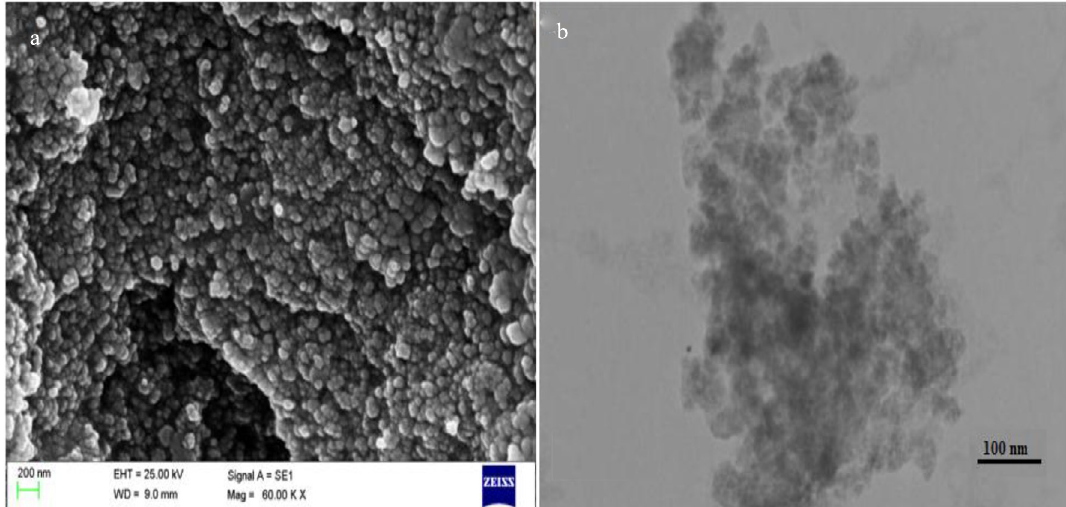
Fig. 2. FE–SEM image (a) and TEM image (b) of as synthesized magnetic